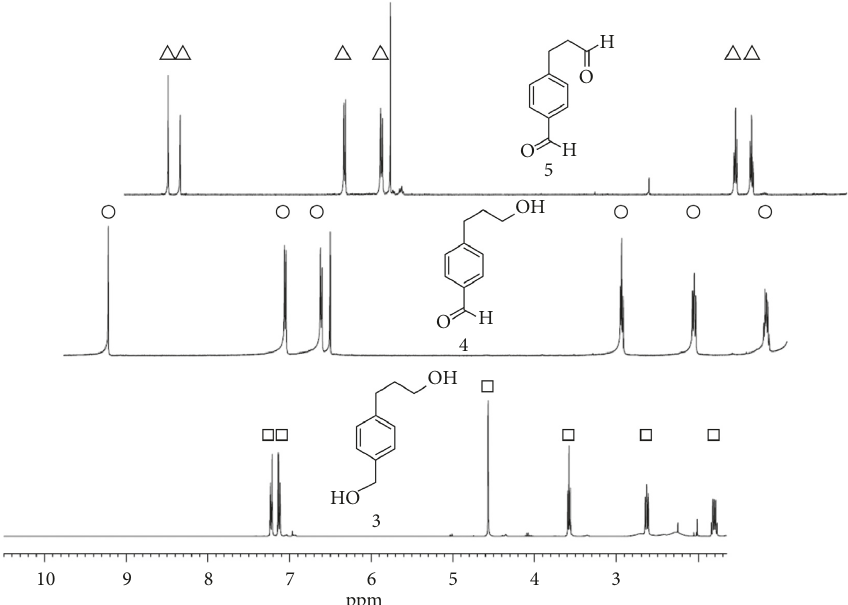
Figure 1: 1 H NMR characteristic identification of compounds 3 ( □ ), 4 ( ○ ), and 5 ( ∆ ).